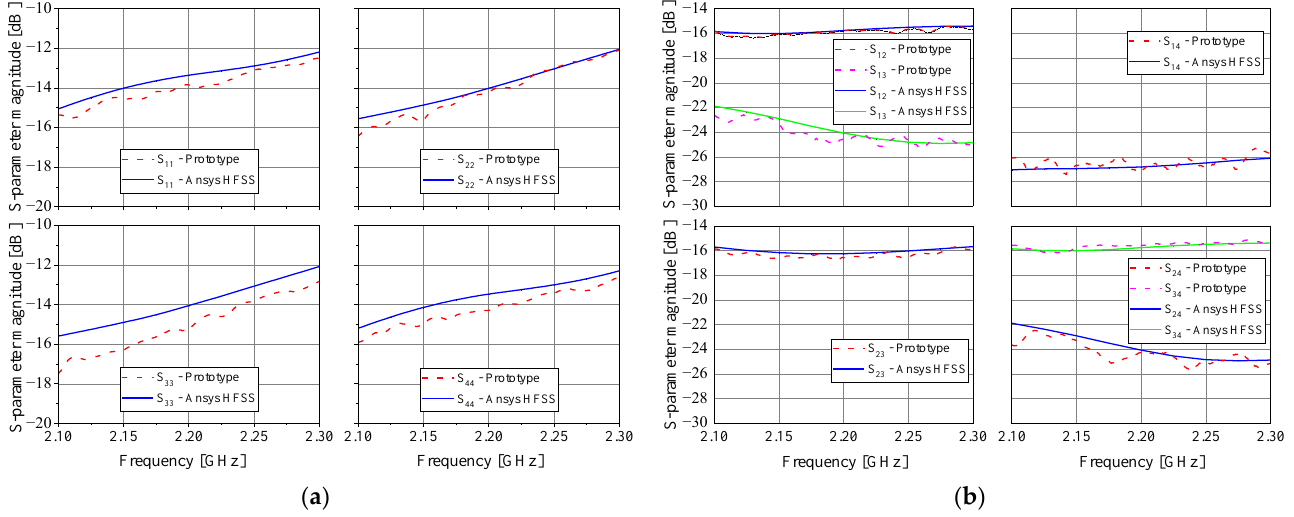
Figure 4. Printed monopole array: ( a ) Geometry dimensions; ( b ) Prototype.